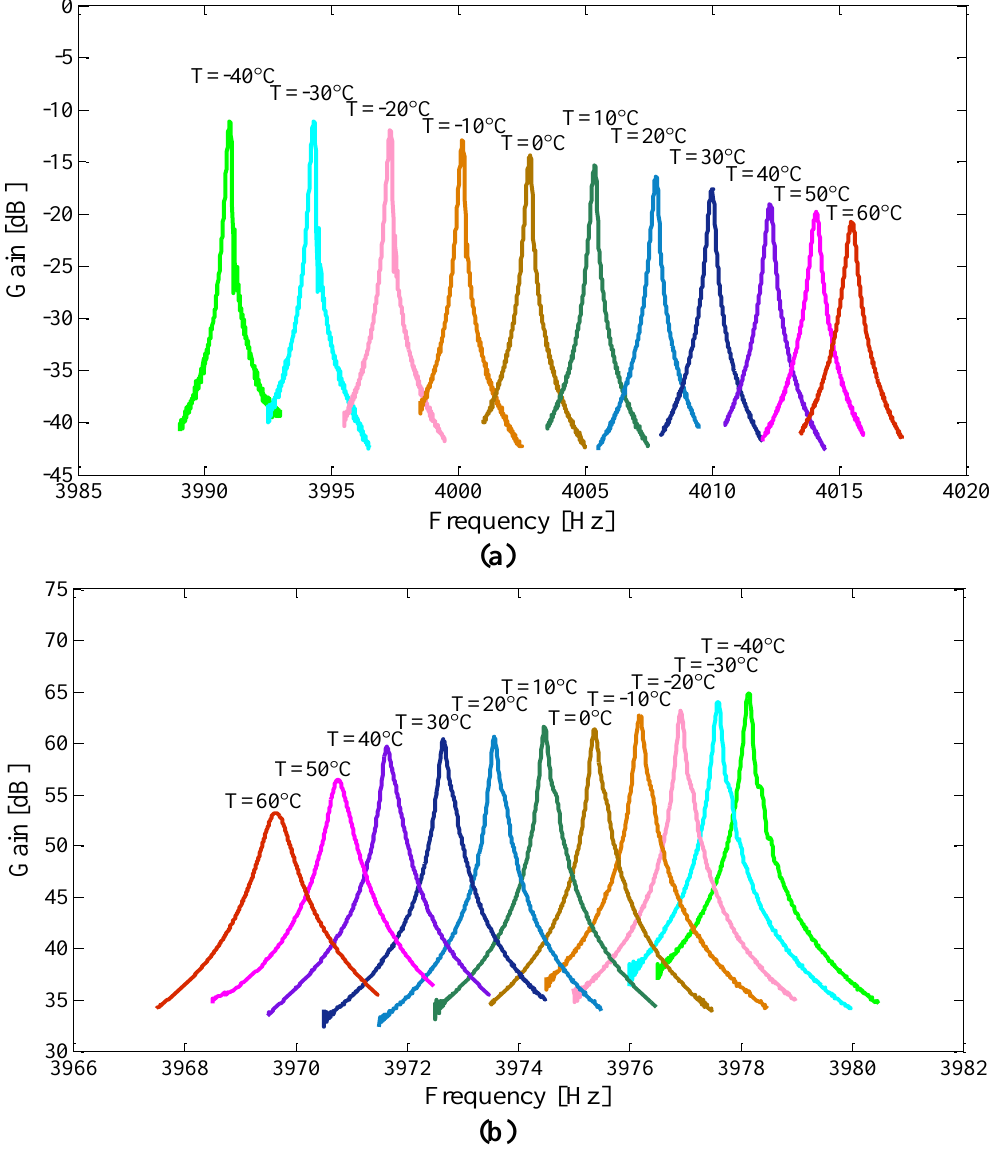
Figure 10. The frequency response characteristics of the gyroscope suspended with a C-C beam at different temperature levels, when operating at the same input conditions. ( a ) drive mode ( b ) sense